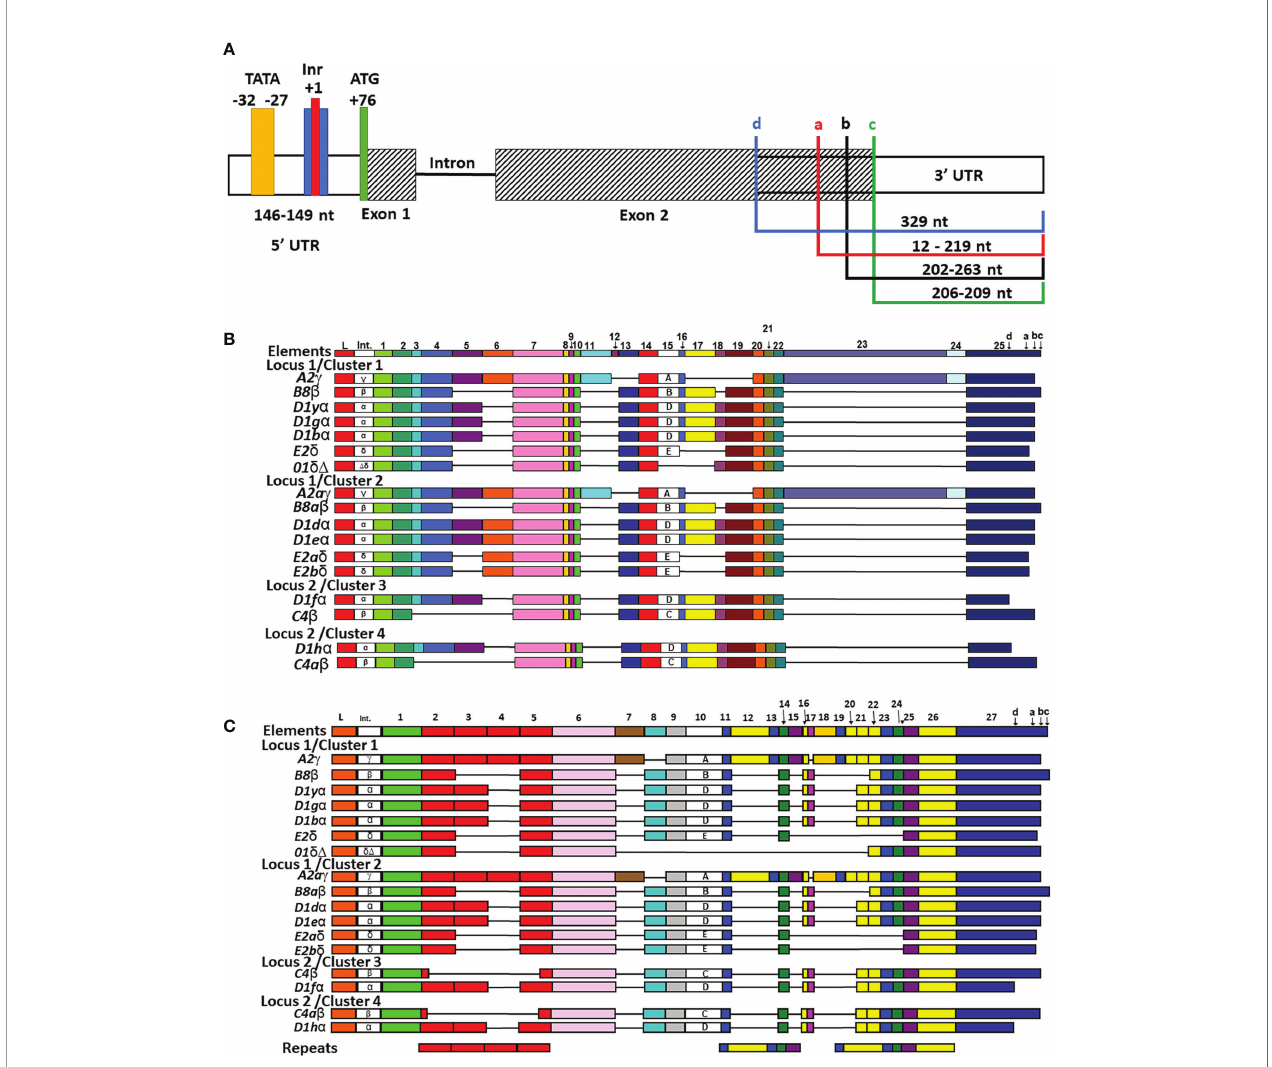
FIGURE 3 | All SpTrf genes are in frame, have identi fi able TATA, Inr sites, one or more stop codons, and most can be aligned with the previously established repeat- based and cDNA alignments. (A) A representative map of the genes shows the 5 ʹ UTR, exons, intron, and 3 ʹ UTR. The 5 ʹ and 3 ʹ UTRs are indicated by white rectangles, the two exons are indicated as striped rectangles, and the intron is indicated by a solid black line. The range in lengths of the 5 ʹ UTR among genes is indicated. The four colored boxes in 5 ʹ UTR indicate putative 5 ʹ regulatory elements and their locations + or – of the conserved +1 A of the start transcription site (red). The TATA box (yellow), the Inr (blue), and the ATG translation start (green) are indicated. The 3 ʹ UTR is variable in length among genes and is indicated by colored brackets showing the four possible locations of stop codons, which are labeled in lowercase ‘ a ’ - ‘ d ’ . (B) The cDNA alignment of genes from the four clusters. The manual alignment was done in BioEdit by adding the genes in the clusters to a pre-aligned set of cDNAs and genes according to previous publications (12, 19). All possible elements are numbered at the top and the four possible stop codons are indicated in element 26. The leader (L), the intron (Int), elements (colored rectangles), and gaps (horizontal lines) are indicated for each gene. Intron type and subtype of element 15 are labeled within each respective rectangle. (C) The repeat-based alignment of the genes from the three clusters. The manual alignment was done as in (B) according to Buckley and Smith (19). All possible elements are numbered at the top and the four stop codons are indicated in element 27. The leader, intron, intron type, elements, subtype of element 10, and gaps are indicated as in (B) . The six types of repeats in the gene sequence are indicated by rectangles of identical color at the